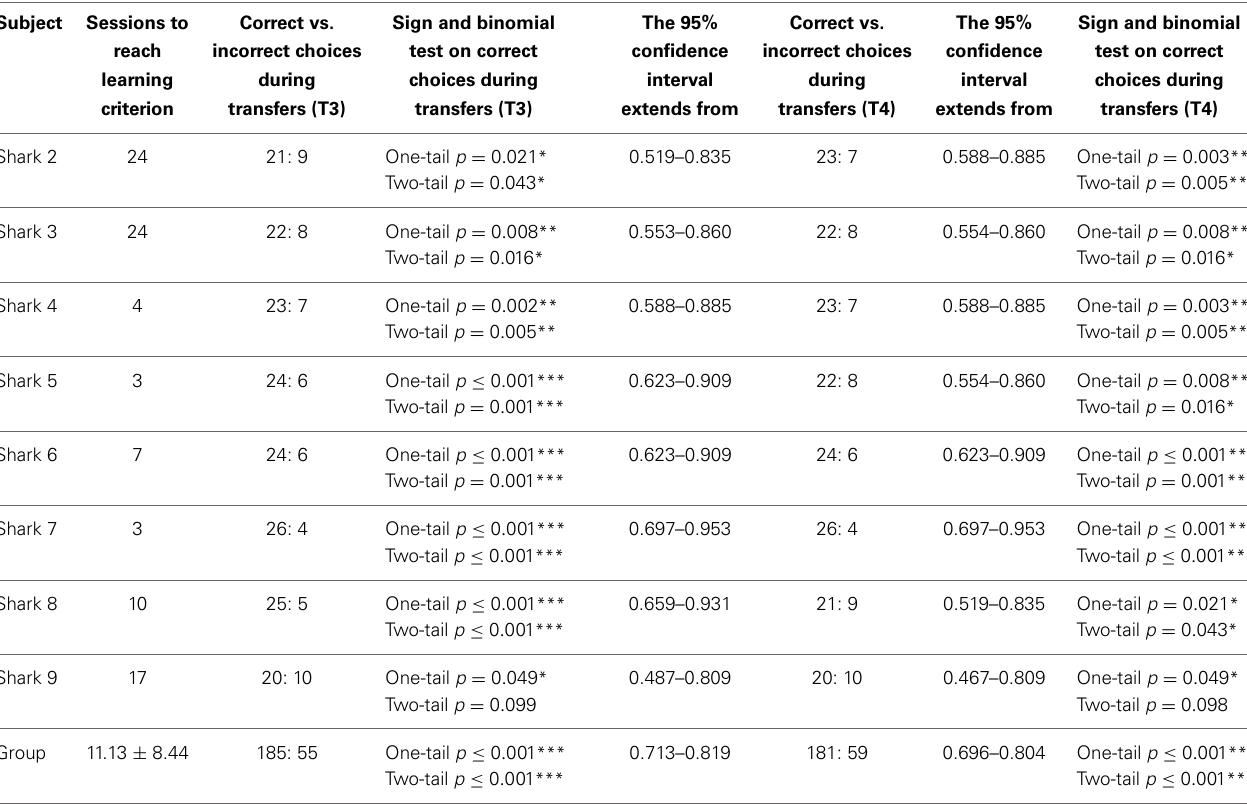
Table 2 | Part 1: Statistics on the performance during regular training trials and transfer tests during Experiment 2: subjective contours. Subject Sessions to Correct